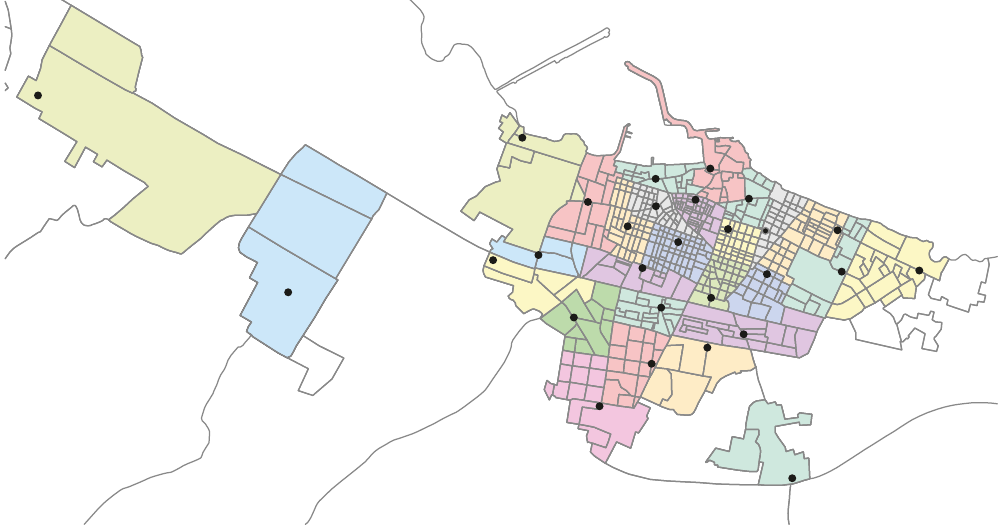
Figure 10: Molfetta case study: traffic zones and centroid